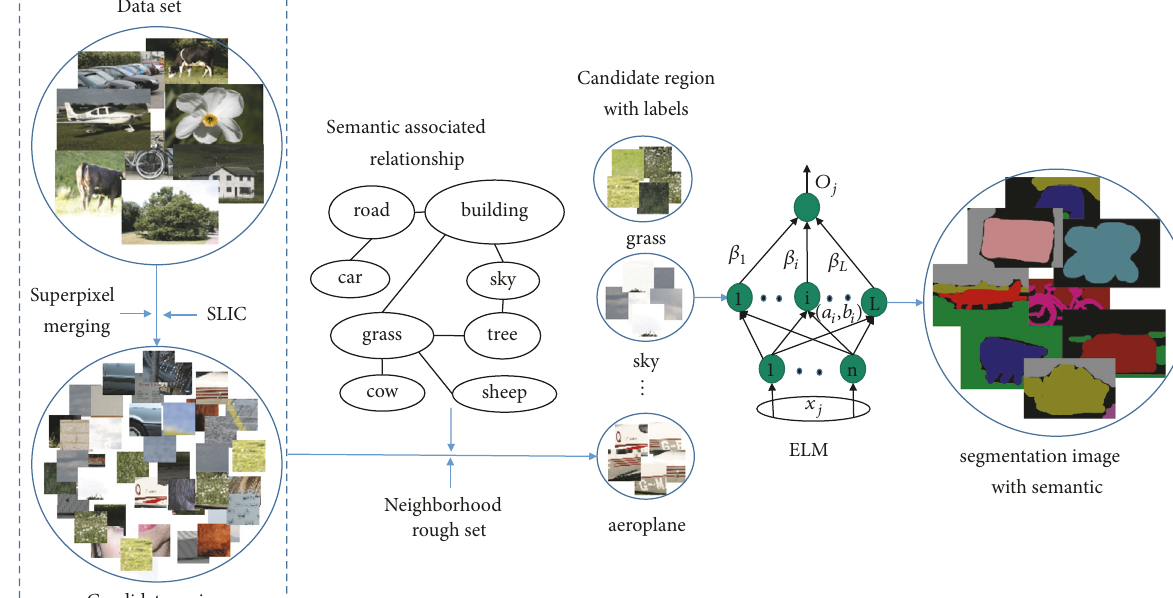
Figure 1: Flow chart of algorithm